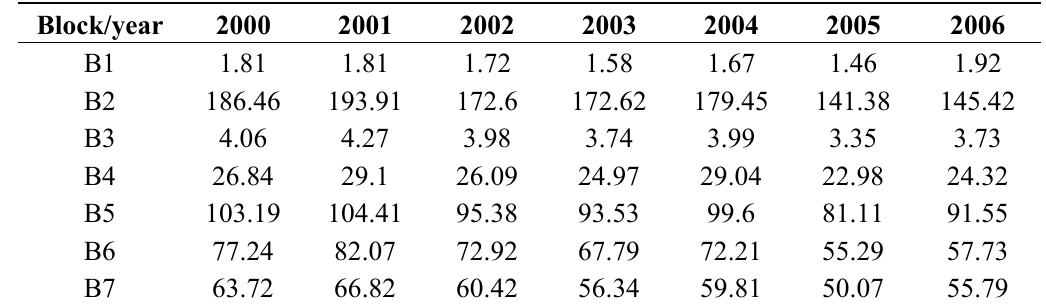
Table 2. Indirect Water Productivity (IWP) in the Castile and León Region, 2000–2006 (€/m 3 , constant prices), irrigation water.